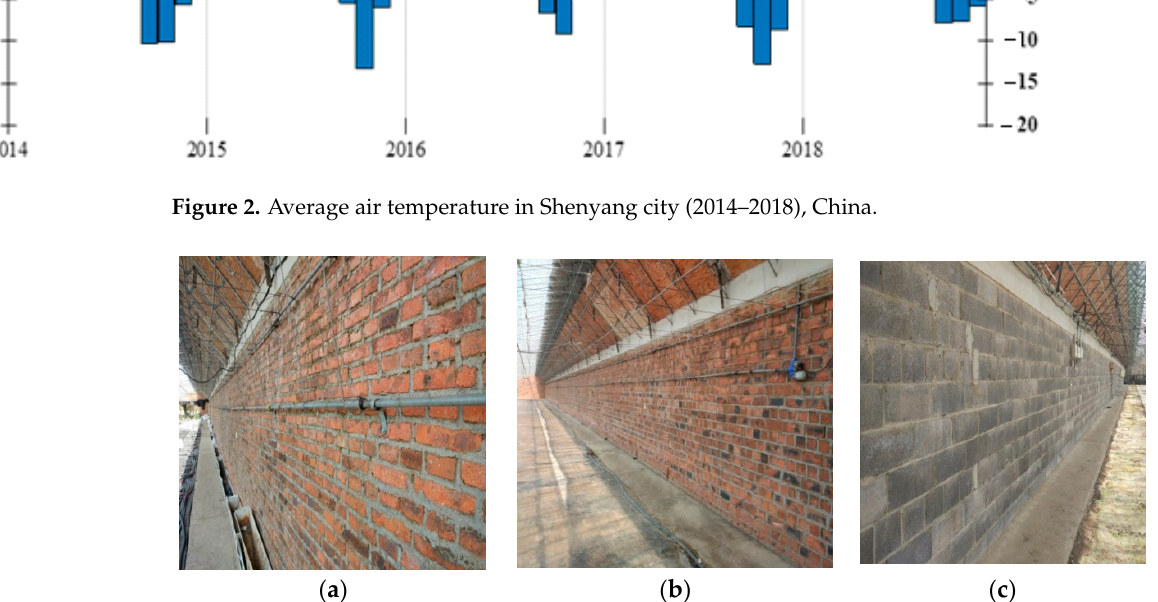
Figure 3. The inside surface of three typical walls used in CSGs. ( a ) Clay brick wall. ( b ) Hollow concrete block wall. ( c ) Fly ash block wall.